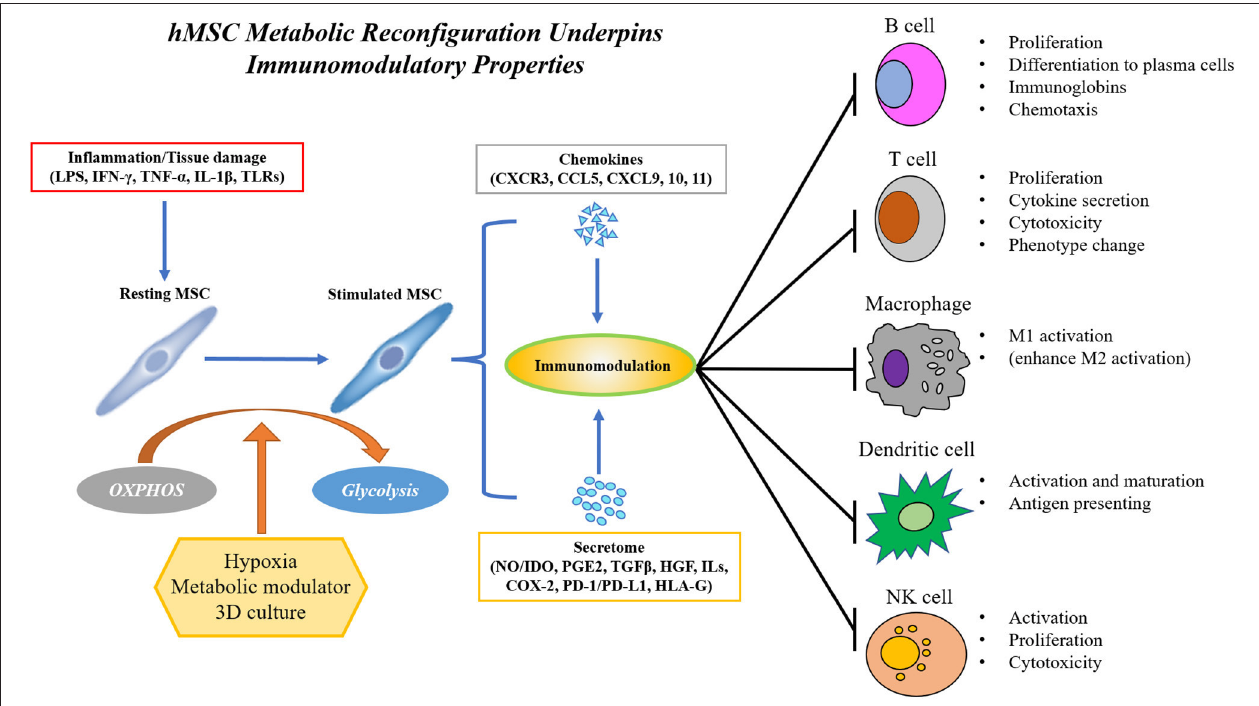
FIGURE 2 | hMSC immunomodulation requires polarization by inflammatory environment and is achieved by the secretion of immunomodulatory factors such as chemokines and cytokines, extracellular vesicles and exosome, and direct cell-cell contact. hMSC’s immunomodulatory property requires a metabolic reconfiguration toward aerobic glycolysis to sustain the production of secretome. hMSC’s immunomodulatory capacity can be enhanced by modulation of hMSC metabolism via hypoxia, small molecule metabolic mediators, or 3D